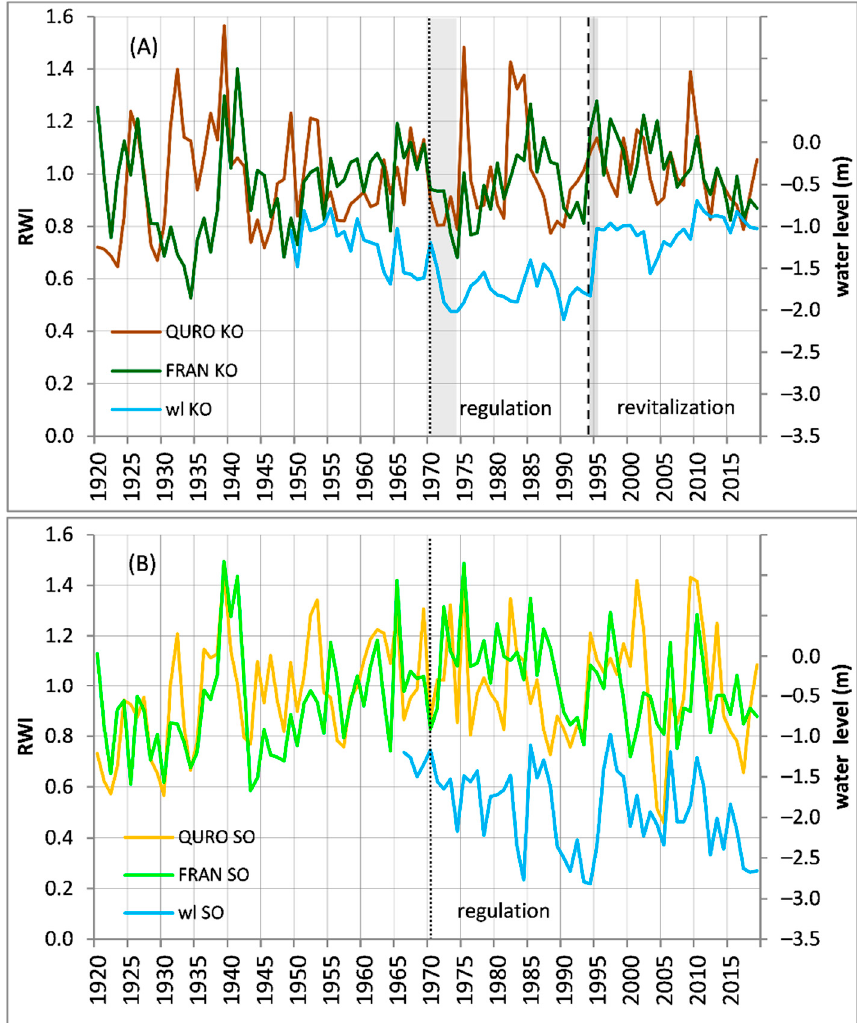
Figure 5. Standard chronologies (RWI100) of Fraxinus angustifolia (FRAN) and Quercus robur (QURO) reflecting medium-to-low variability at sites: ( A ) KO, ( B ) SO. The chronologies are plotted against March–September average water levels (wl). The dotted line shows the date when the river regulation started, while the dashed line shows the date when revitalization started. The gray areas show short-term growth reaction to river regulation and revitalization.